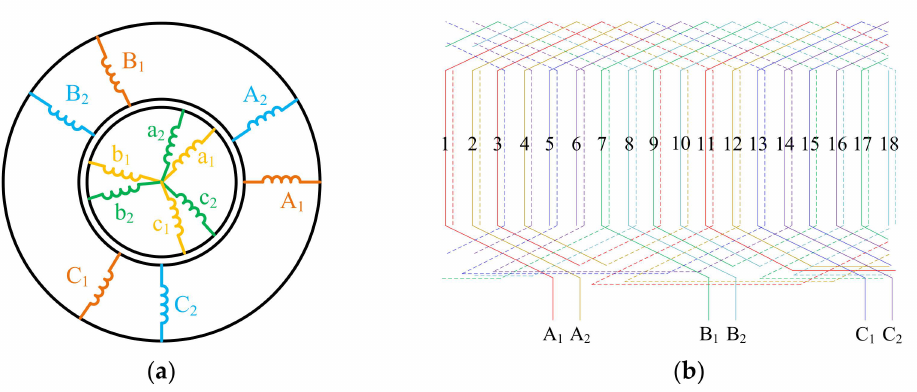
Figure 1. The structure of the DTPIM and the stator windings. ( a ) Motor structure; ( b ) Stator windings structure of a pair of